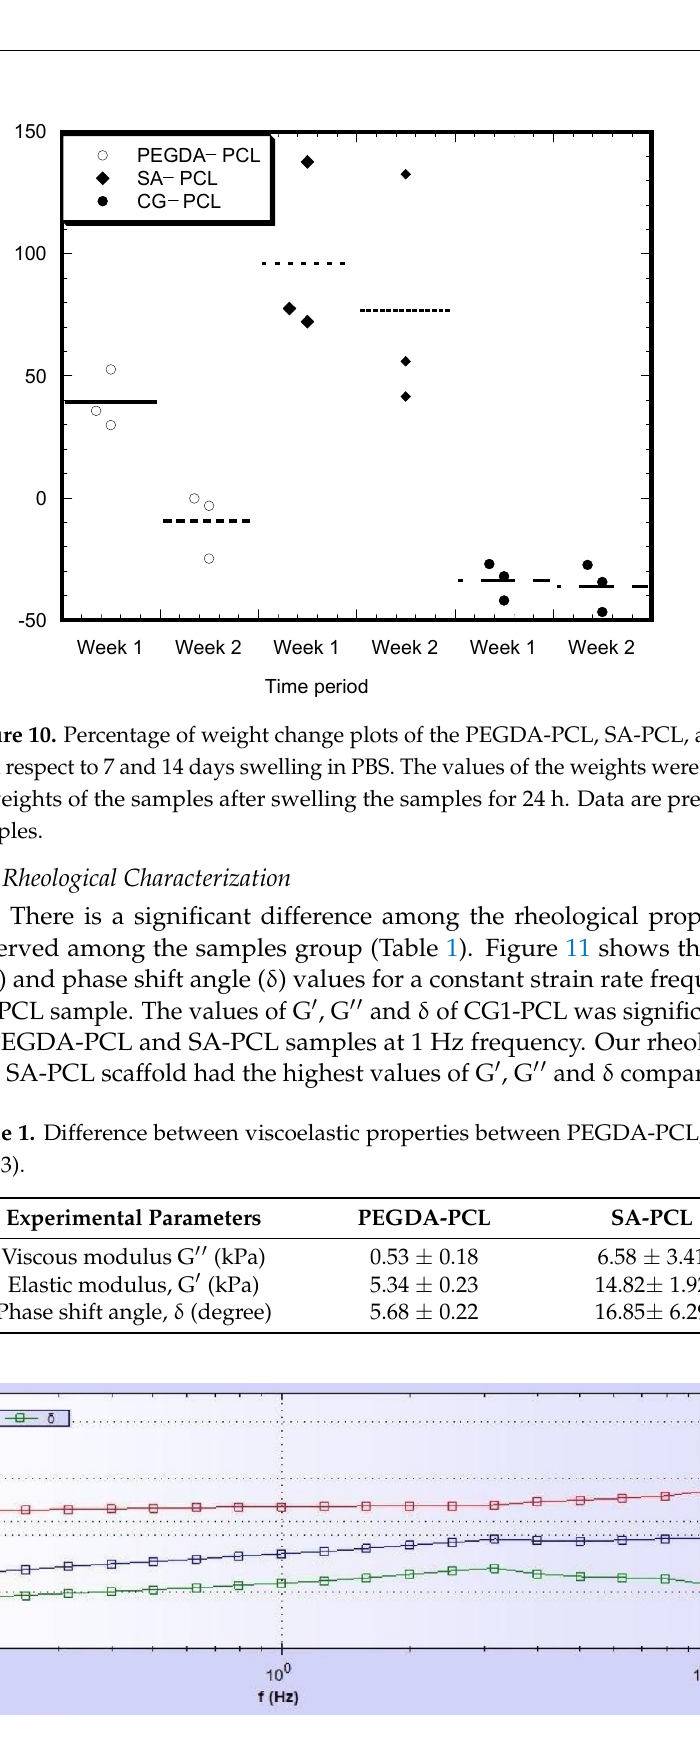
Figure 11. A representative image showing the elastic, viscous and phase shift angle variation during the constant strain rate frequency sweep test at 25 °C. In the image, G ′ , G ″ and δ are the elastic, viscous and phase shift angle, respectively. Table 1. Difference between viscoelastic properties between PEGDA-PCL, SA-PCL and CG1-PCL ( n = 3).